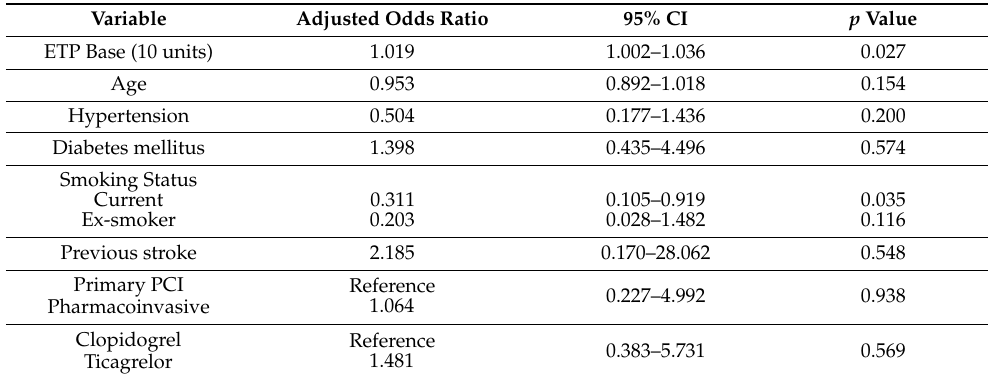
Table 4. Predictors of scar increase measured by late gadolinium enhancement on cardiac magnetic resonance